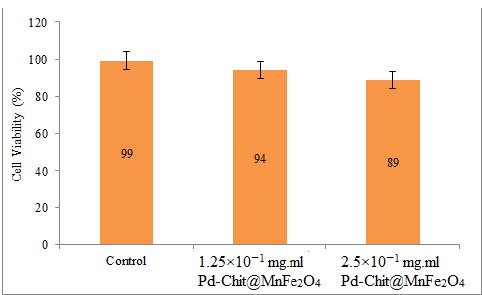
Figure 8. Cytotoxicity of Pd − Chit@MnFe 2 O 4 on HeLa cells at 24 h.